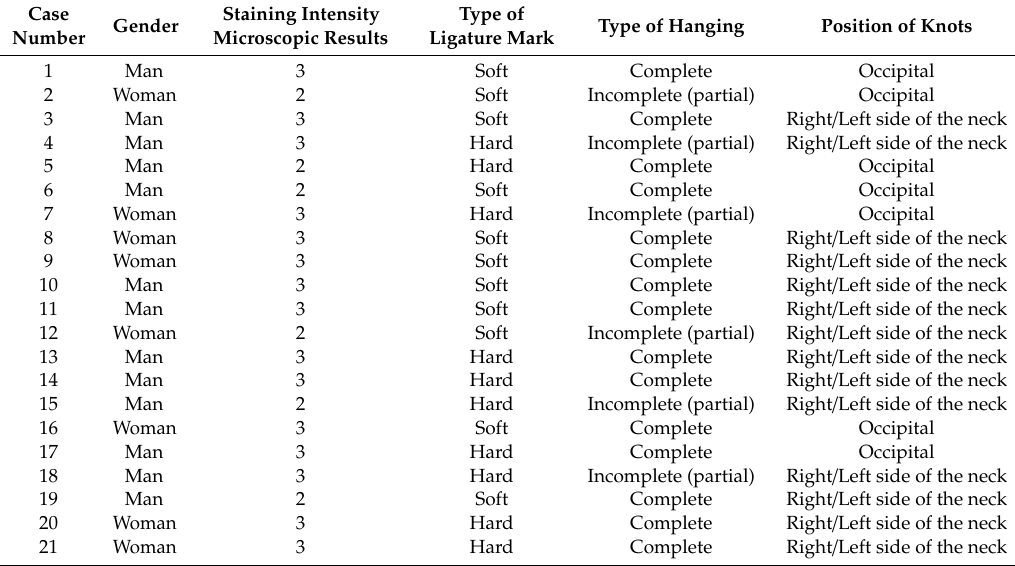
Figure 3. ( A ) Evident intracytoplasmic depletion of FLIP was appreciated in the epidermal layers with coexistence of epidermal flattening especially marked in the basal and spinous strati ( × 60). ( B ) (Insert of A) At higher magnification, the passage from the uninjured skin to the compression zone (ischemia) is clearly distinguishable (red arrow indicates the passage of the clear “ax blow” hypo-expression). Coexistence of epidermal flattening is especially marked in the basal and spinous strati (black arrows, × 200). Table 1. Quantitative analysis and circumstantial data: staining intensity was evaluated using a semi- quantitativeimmunohistochemicalscoringscale(averagevalueofintensity − 2.71, statisticallysignificant ( p < 0.05)). In all cases we investigated the skin at the level of the “full of the loop” (greater compression of the ligature